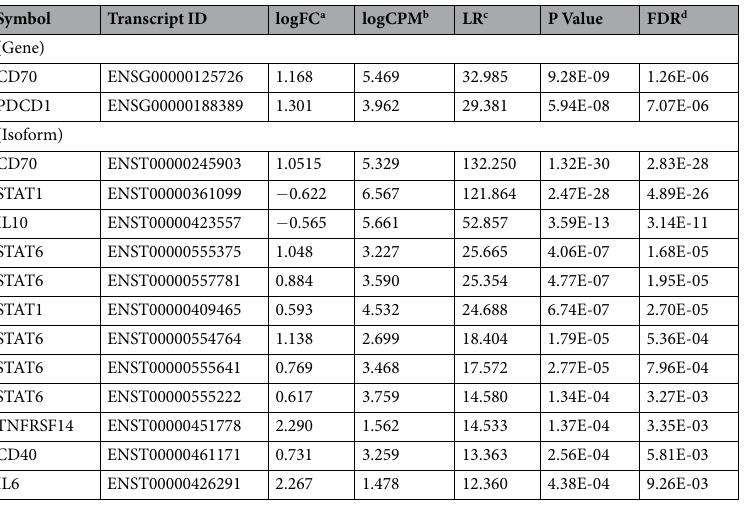
Table 2. Differential expression of genes in the poor prognosis subgroup, compared to the good prognosis subgroup. Note: a FC; fold change, b CPM; counts per million, c LR; likelihood ratio, and d FDR; false discovery rate. Subgroups were divided by the median overall survival of PCNSL patients